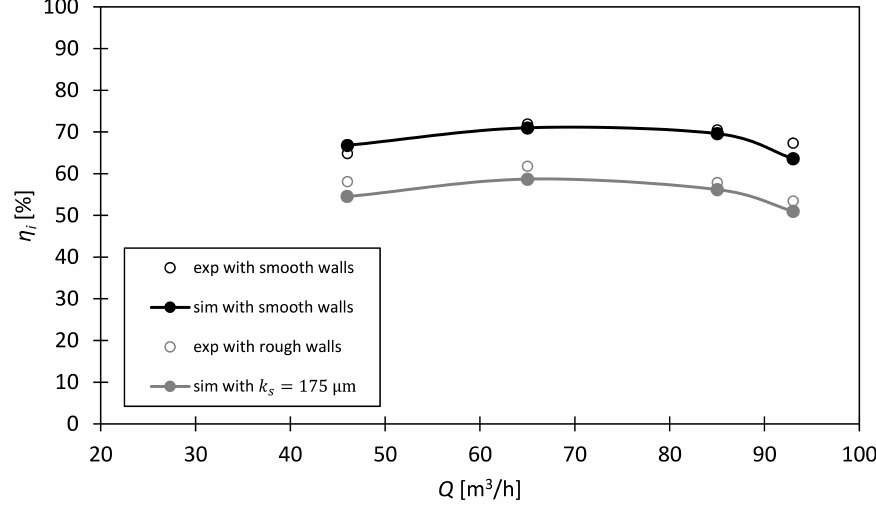
Figure 23. Experimentally and numerically assessed efficiency curve η i = f ( Q ) of the radial turbop- ump. Please note: the measurement uncertainties of the pump characteristics are not displayed but were less than 1% of the mean values.